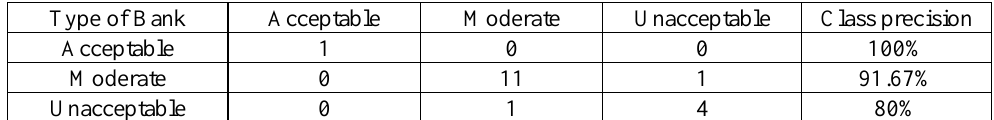
Table 6. Naive Bayes algorithm